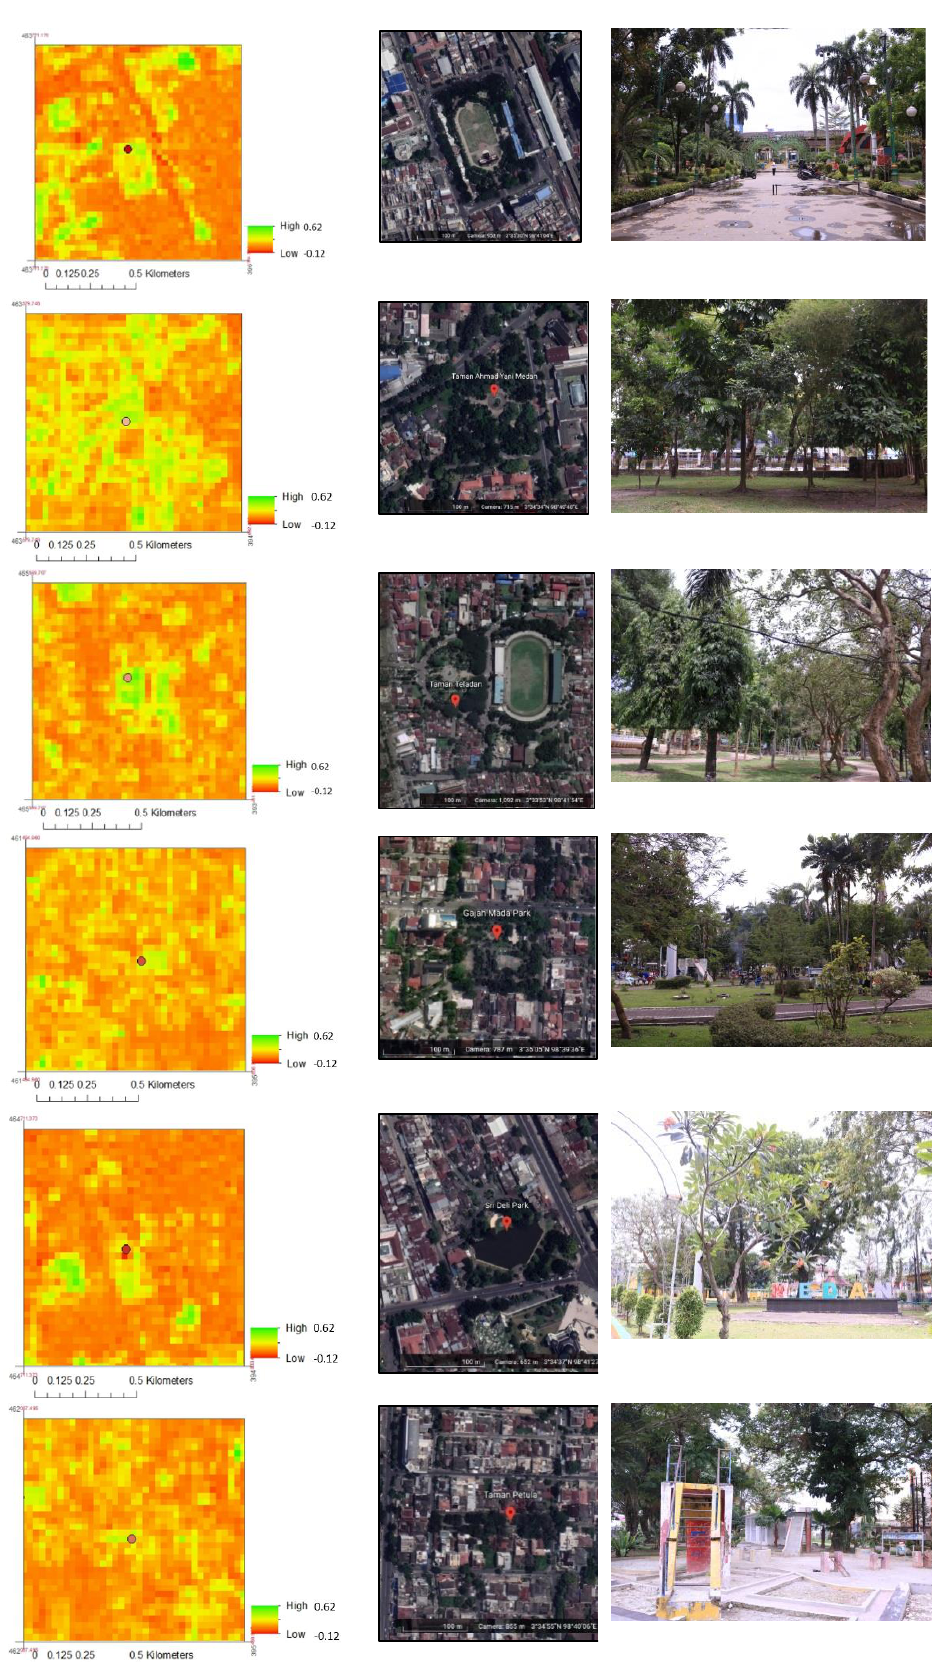
Figure 8. Parks’ overview in NDVI, Google Earth image, and in the field.